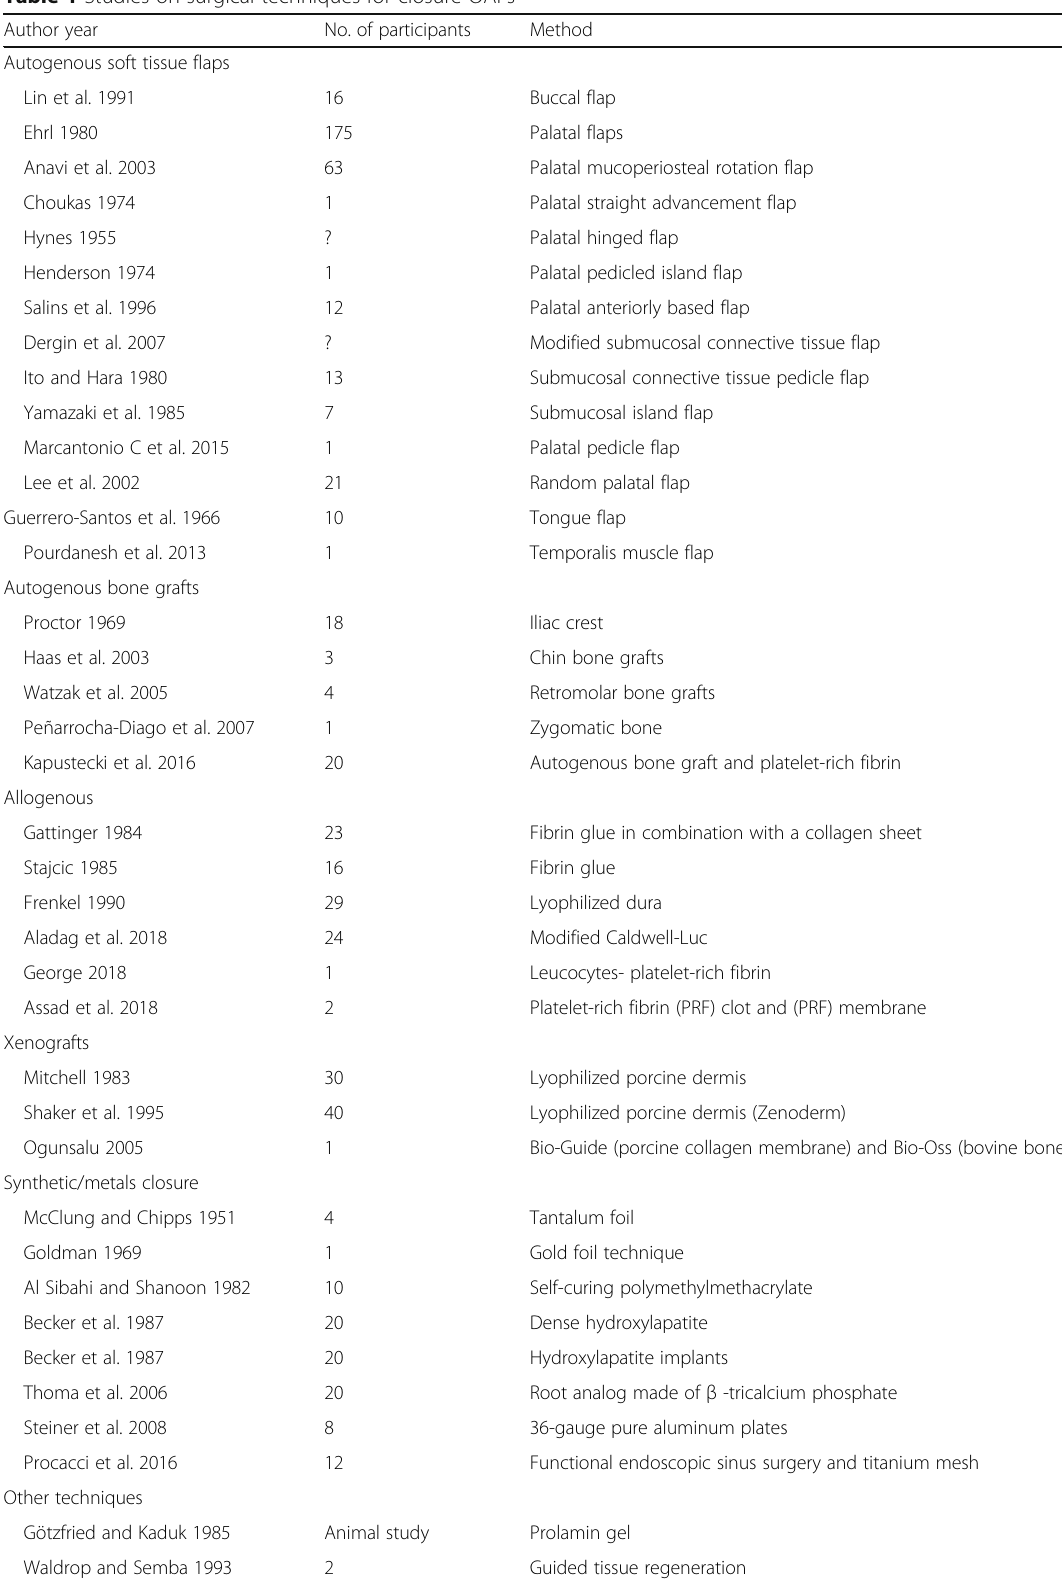
Table 1 Studies on surgical techniques for closure